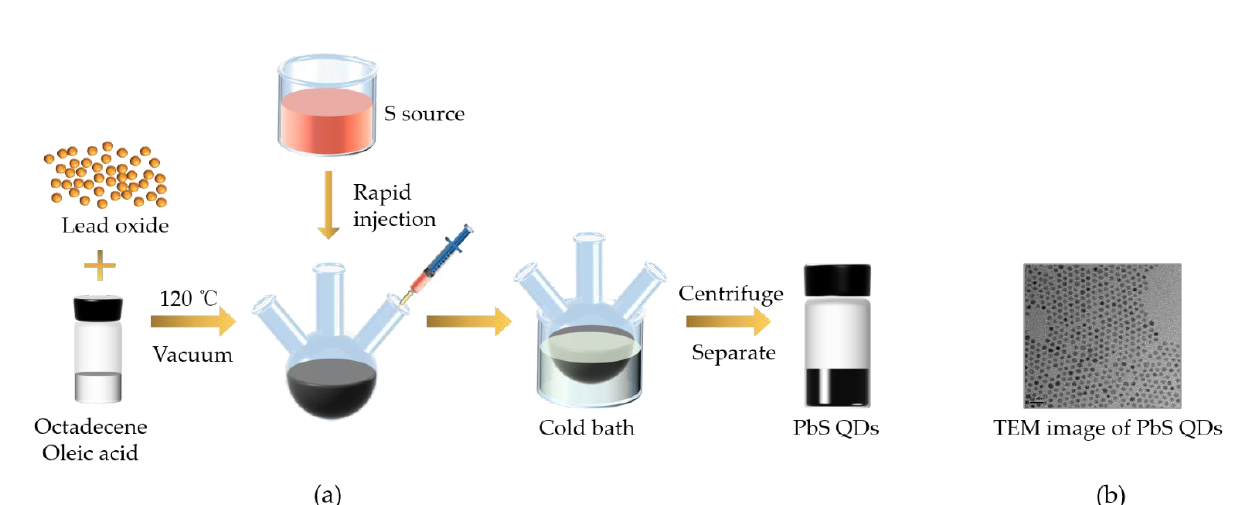
Figure 1. ( a ) The principle diagram of PbS quantum dots (PbS QDs) preparation. ( b ) The transmission electron microscope (TEM) image of PbS QDs.